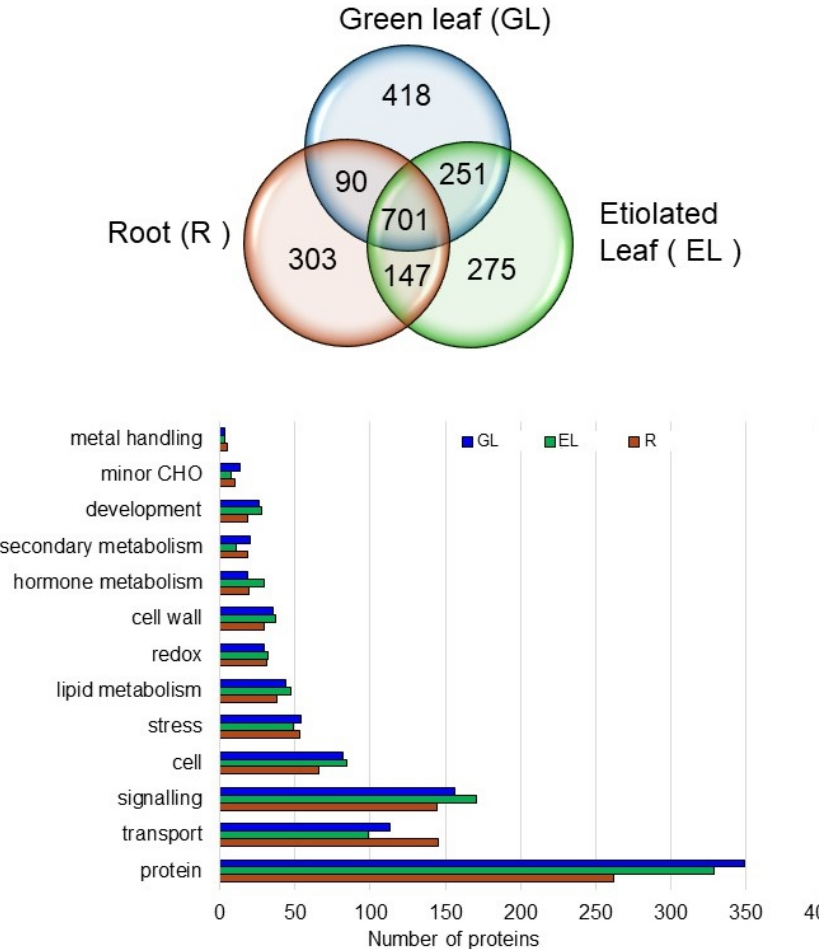
Figure 5. Functional protein categories and Venn diagram showing the number of common and organ-specific proteins in the plasma membrane fractions of the root (R), greening leaf (GL), and etiolated leaf (EL) in 1-week-old rice plants. The plasma membrane proteins were functionally categorized using the MapMan bin codes. Category “cell” contains cell organization, cell division, cell cycle, and vesicle transport. Category “protein” comprises protein degradation/synthesis/targeting/PTM/amino acid activation/folding.